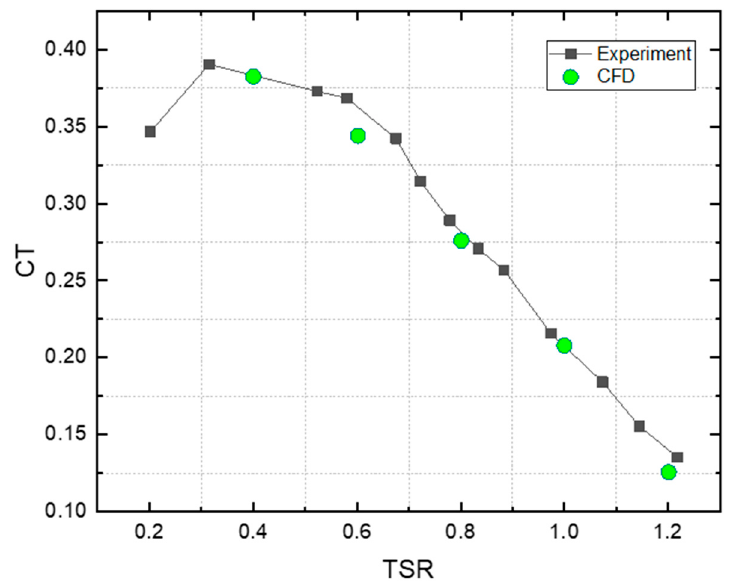
Figure 8. Numerical method validation.